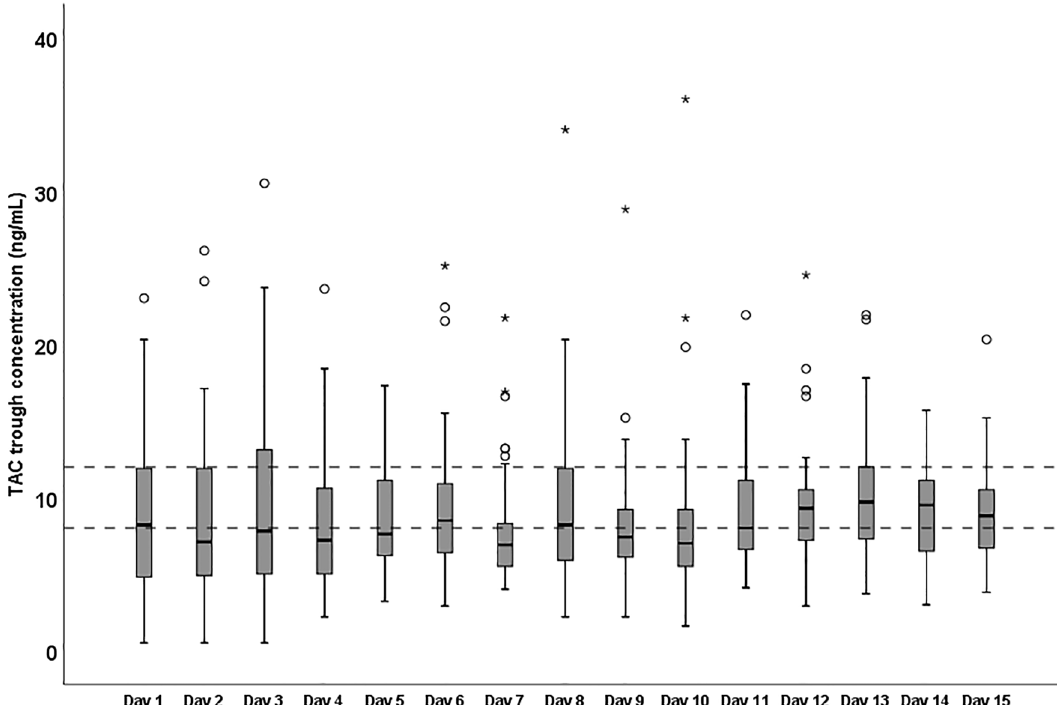
Figure 1. Daily TAC blood concentration after liver transplant. TAC,